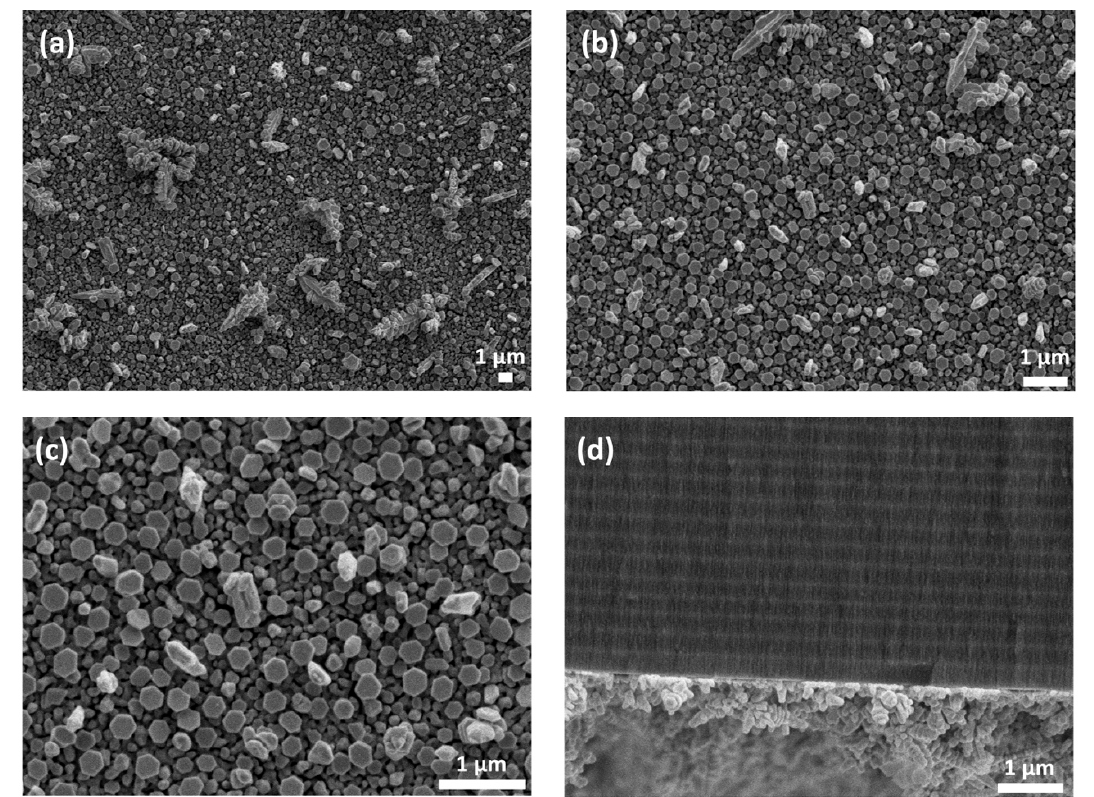
Figure 8. FE-SEM images of Ag NPs, formed on sample RF S2 by immersion plating for 5 min in 10 − 2 M AgNO 3 . ( a – c ) Top view micrographs at three magnifications; ( d ) cross-section view.